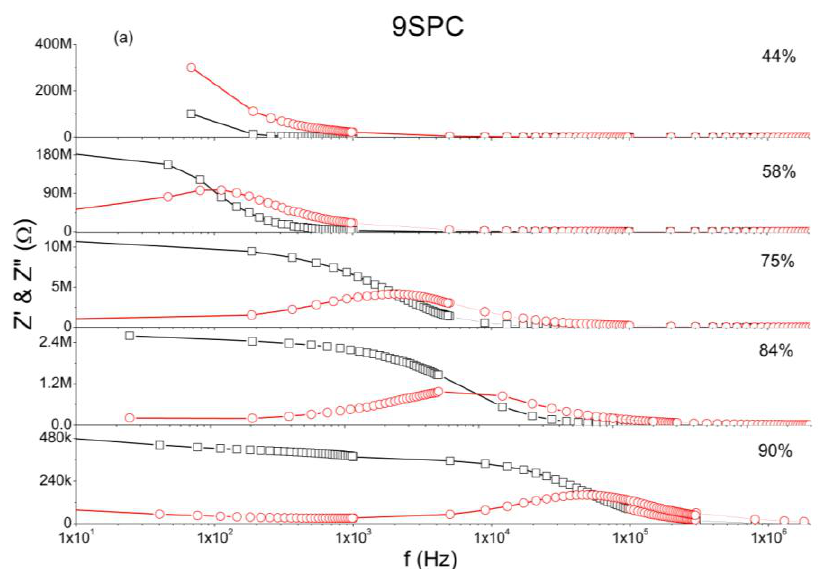
Figure 4. Real (Z´, square symbols) and imaginary (Z´´, circles) parts of the impedance versus frequency, for various relative humidity values. All measurements were presented in the same horizontal scale as function to the log of the frequency. The straight horizontal lines were employed to separate the different RH% environments. The results were presented in: ( a ) for the sample 9SPC and ( b ) for the sample